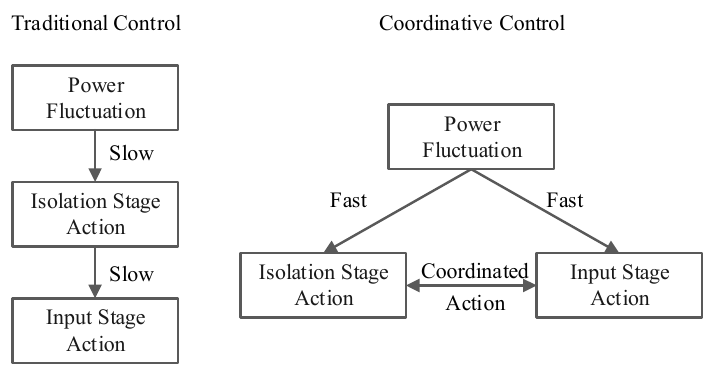
Figure 8. C ontrol logic of the independent control and proposed coordinative control. Figure 8. Control logic of the independent control and proposed coordinative control.